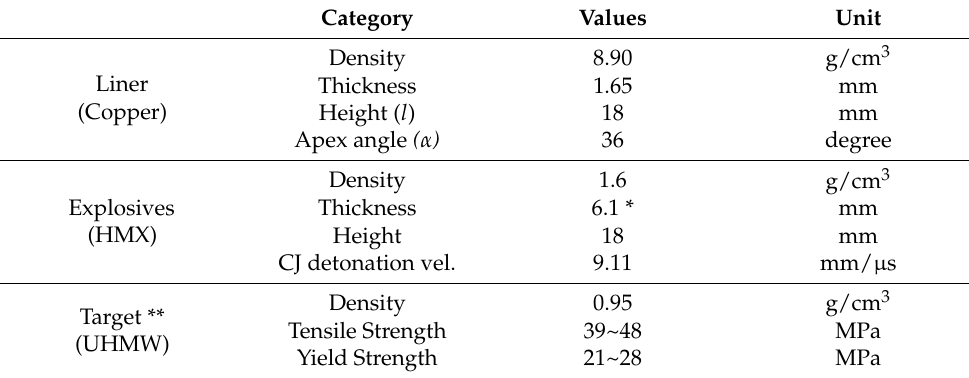
Table 1. Properties of LSCs and the mechanical properties of UHMW targets [5]. Figure 1. Schematic diagram of the LSC test configuration.